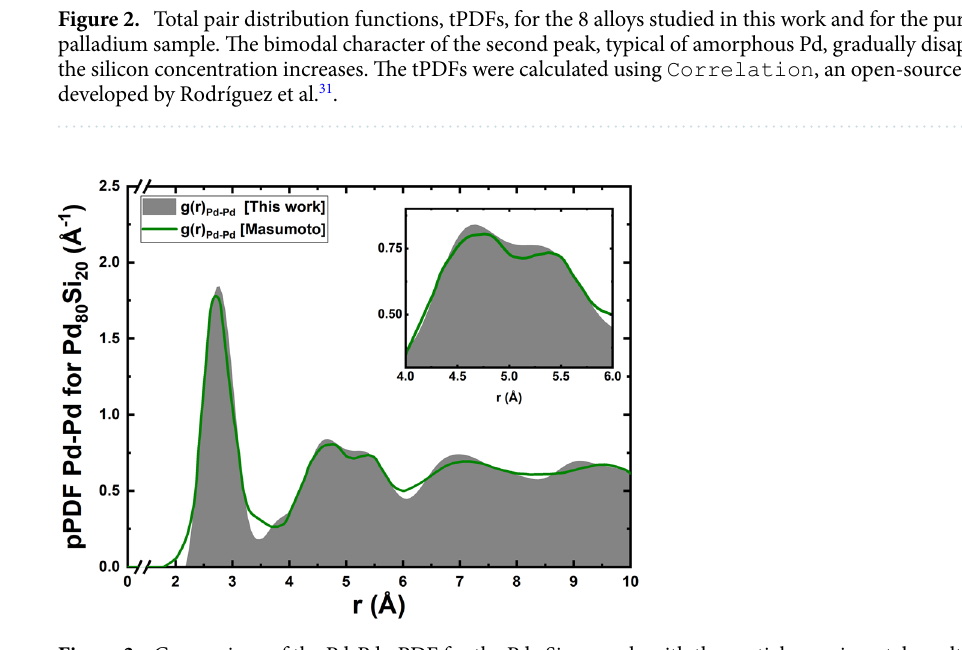
Figure 3. Comparison of the Pd-Pd pPDF for the Pd 80 Si 20 sample with the partial experimental result of Masumoto (in Waseda’s book 27 ) 26 . The bimodal elephant-like nature of the second peak is depicted in the